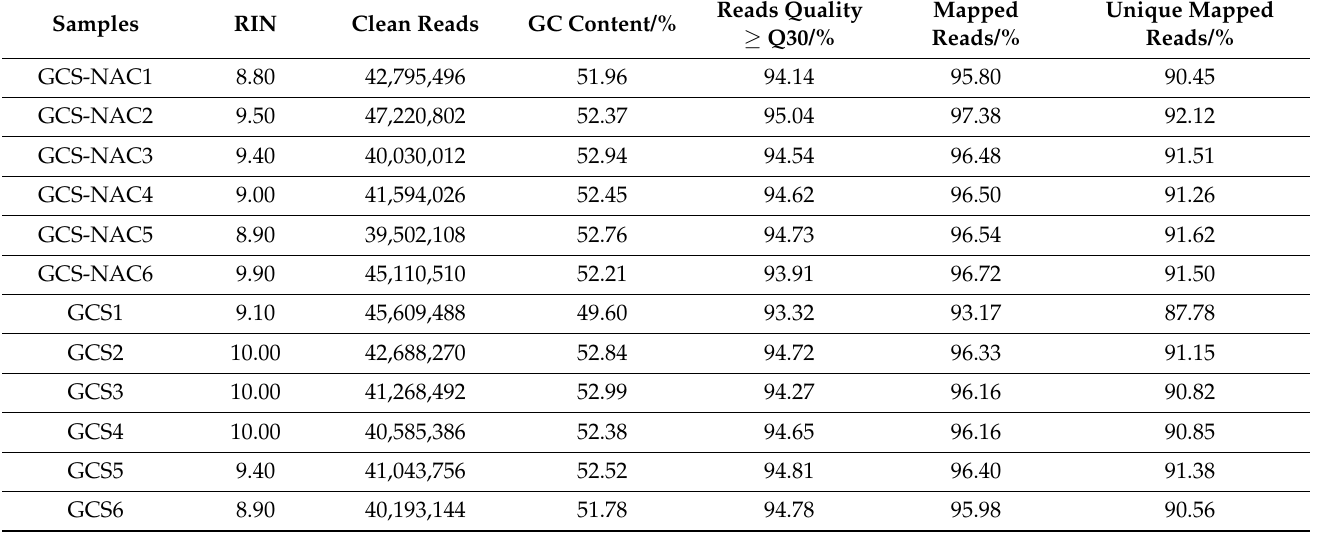
Table 3. Quality control and sequencing data